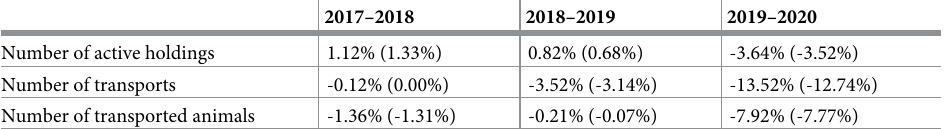
Table 3. Recorded annual variation in pigs holdings and movements. Observed variations (%) in the whole database and in the industry (in